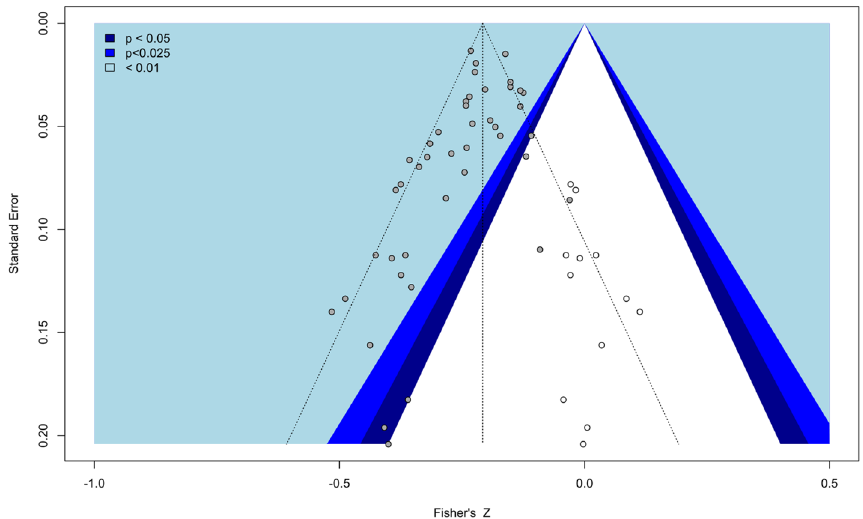
Figure 2. Contour funnel plot indicating potential risk of publication bias. Open dots represent the 12 studies imputed to achieve symmetry.